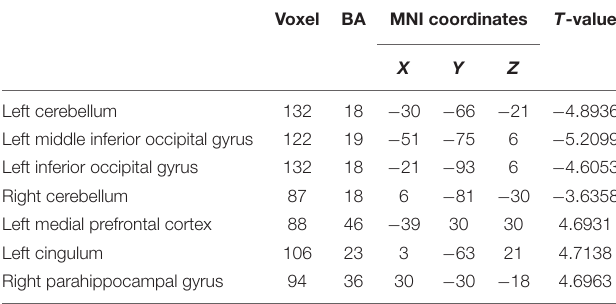
TABLE 1 | Characteristics of TOF and healthy children.